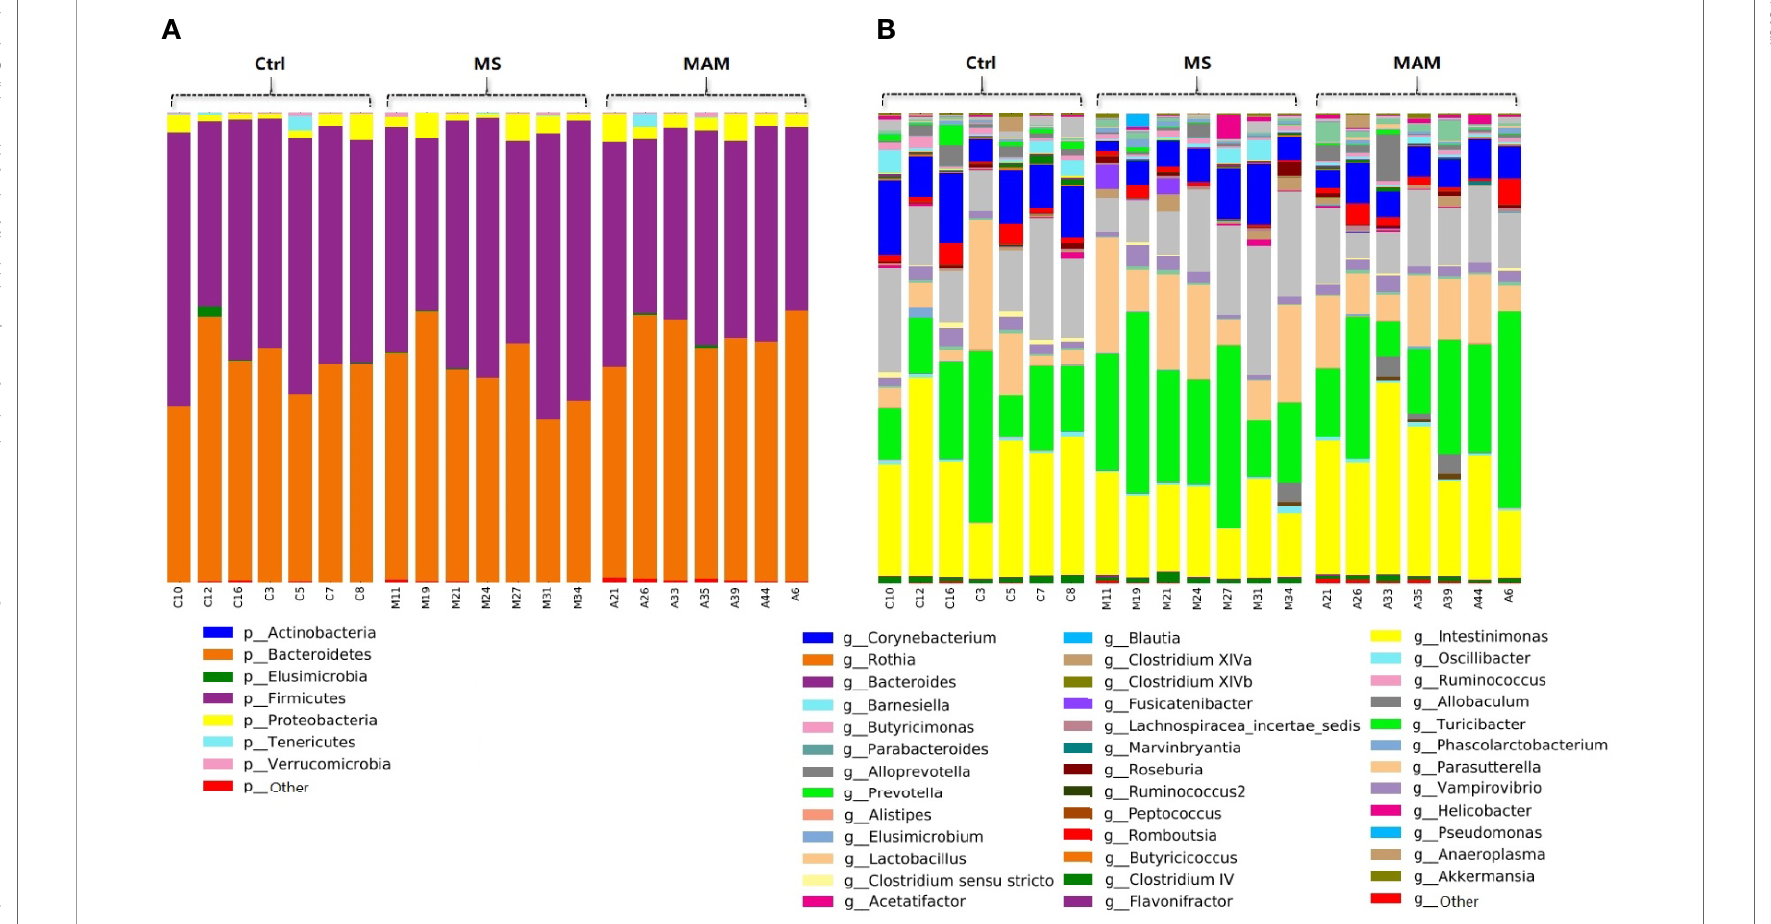
FIGURE 2 | Bar plots of the gut microbiota compositions of each samples in 3 groups. (A) annotated at phylum level; (B) annotated at genus